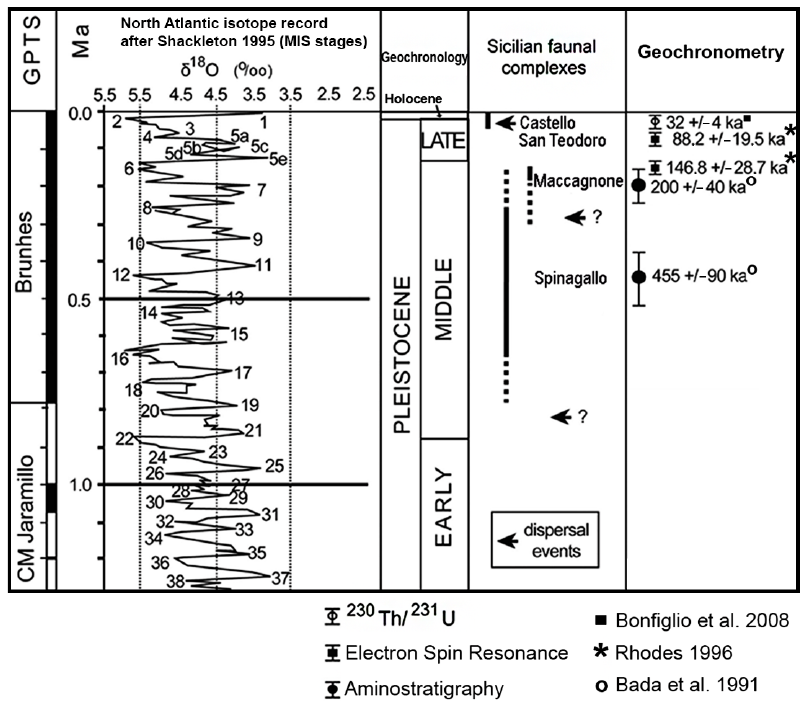
Figure 2. Chronological distribution of Sicilian faunal complexes shown in the frame of marine isotope stages (MIS). CM, Cobb Mountain subchron; GPTS, geo-magnetic polarity time scale. The question marks indicate uncertain times and ways of dispersals. (from Refs [4,5,13,14] modified). Correlations of cave deposits with the marine isotopic stages can provide an additional independent tool to date fossiliferous deposits. In the strongly uplifted northeastern Sicily, up to six orders of marine terraces may be found from 600 m to 25–30 m a.s.l. [15,16]. Only the widest terrace, located between the altitudes of 150–135 and 60 m a.s.l., has been